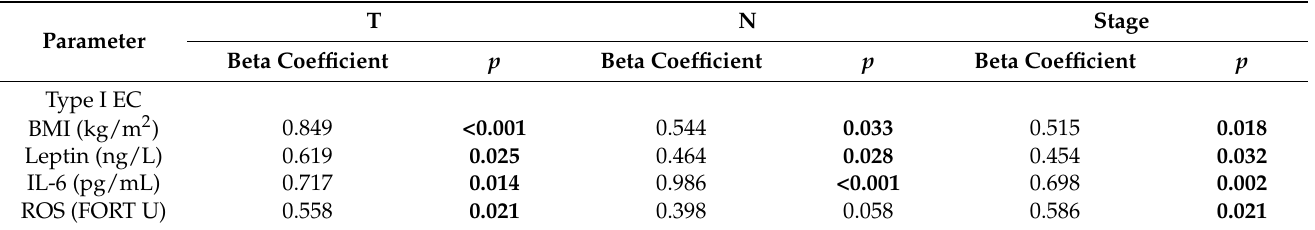
Table 8. Multivariate regression analysis of BMI, leptin, proinflammatory cytokines, and oxidative stress parameters with regard to standard tumor prognostic factors in type I endometrial cancer